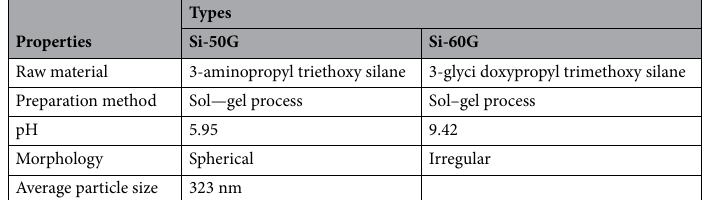
Table 6. Physico-chemical properties of Si preparation.